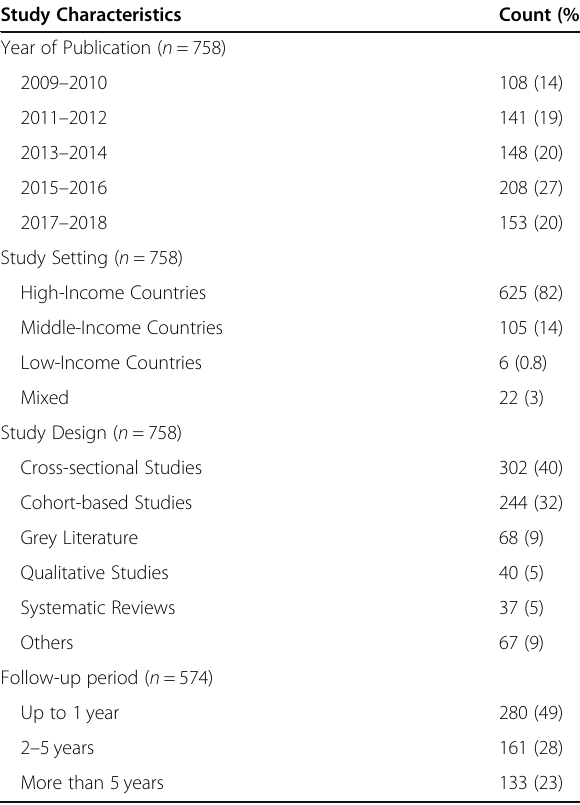
Table 1 Characteristics of the Included Articles Study